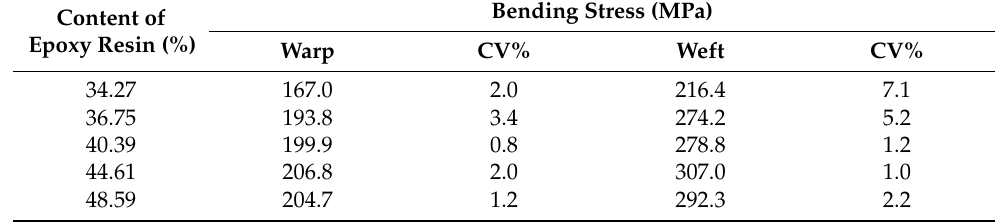
Table 4. The bending properties of materials with different contents of epoxy resin.